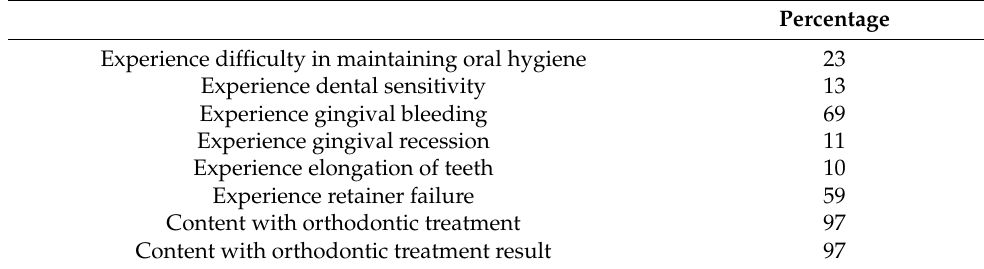
Table 2. Patient-reported outcomes in retainer patients (N =